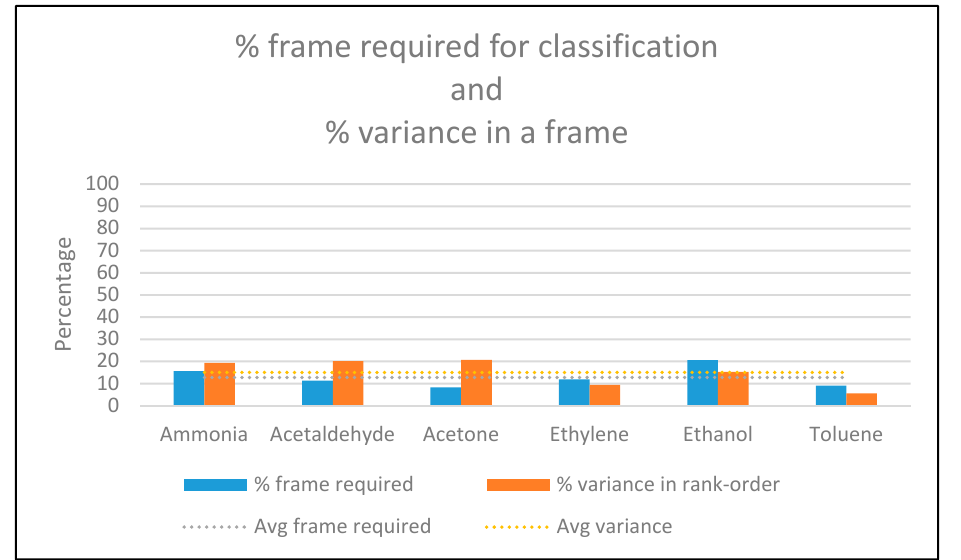
Figure 8. Graph plot to analyze the dependency of pattern-frame required for classification on inconsistencies in rank-order patterns observed for experiments conducted with [20] dataset .